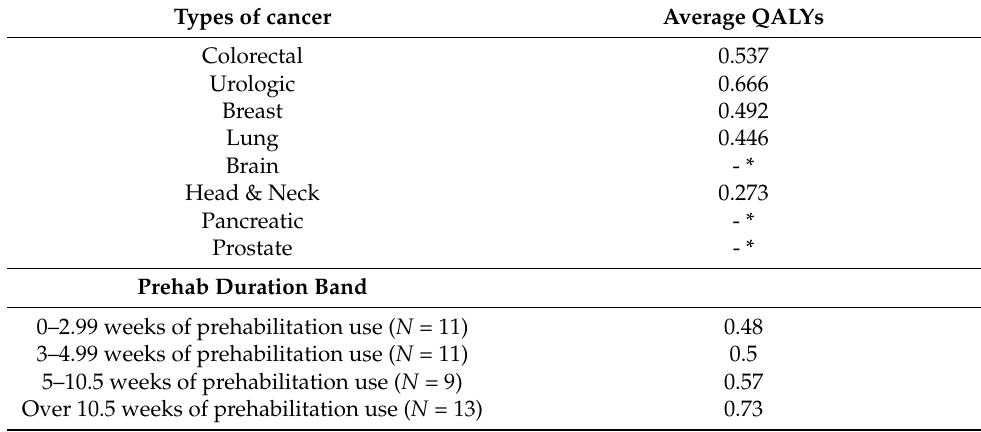
Table 3. Average QALYs per cancer type group or prehabilitation duration band.